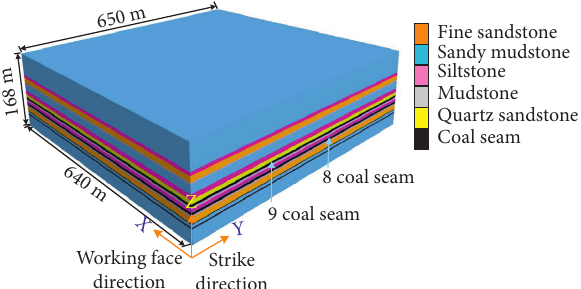
Figure 8: Three-dimensional numerical simulation model.